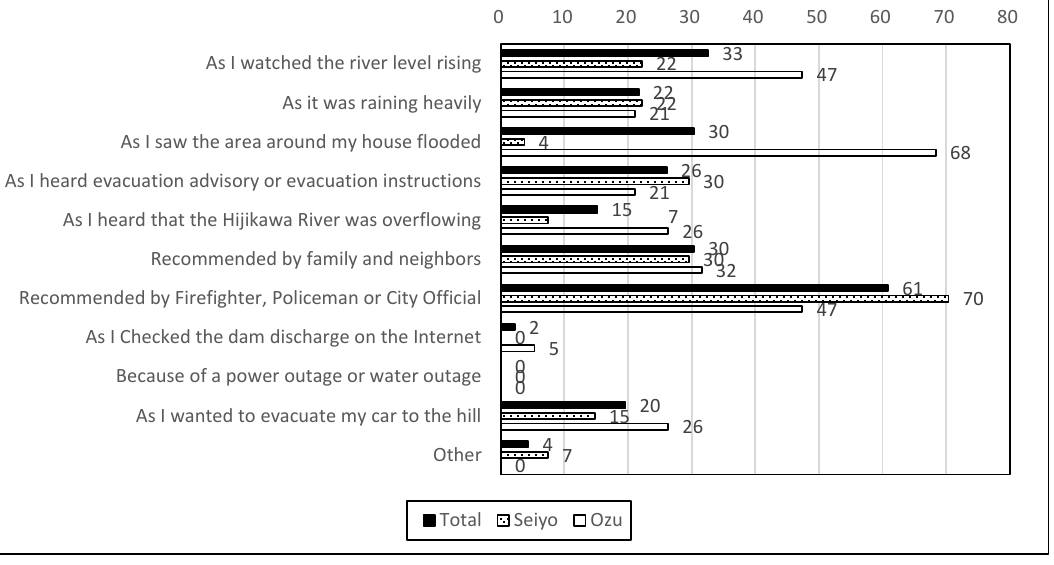
Figure 15. Trigger of early evacuation (%), n = 46.